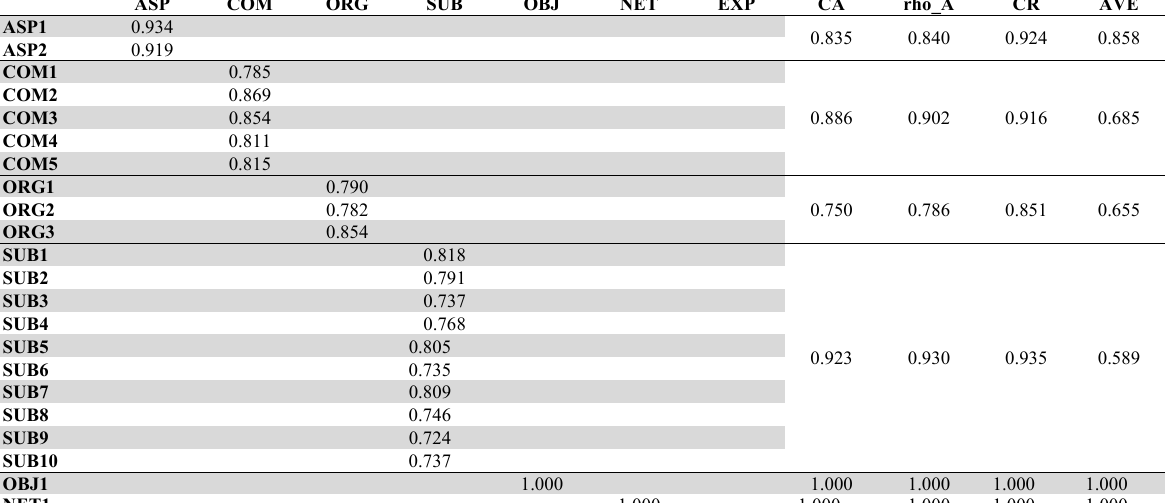
The results of CA, CR, AVE and Outer